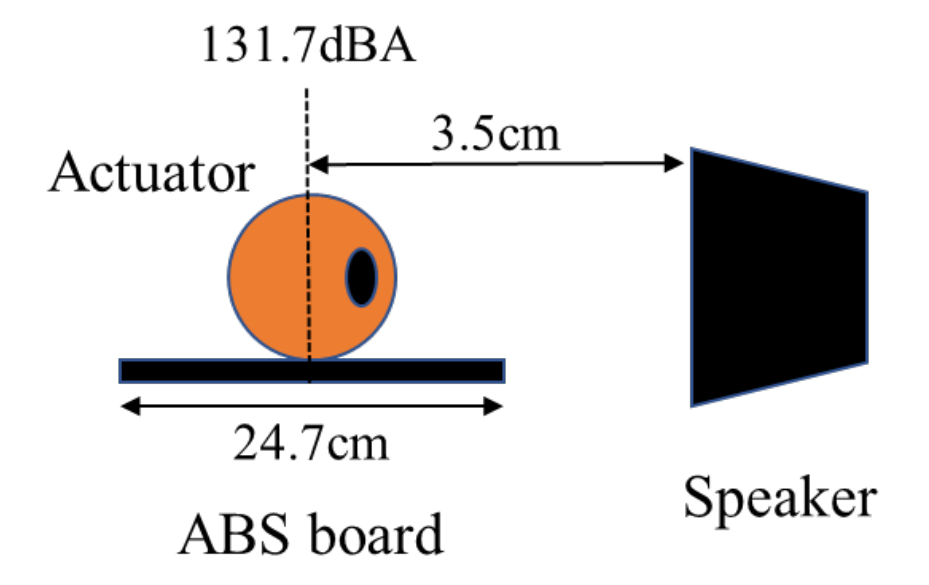
Figure 9. Experimental setup.